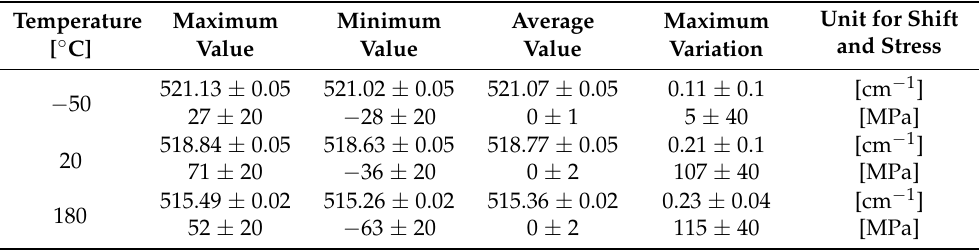
Table 4. Raman shift [cm − 1 ] and stress values [MPa] obtained for the Si_Unmounted sample. Temperature